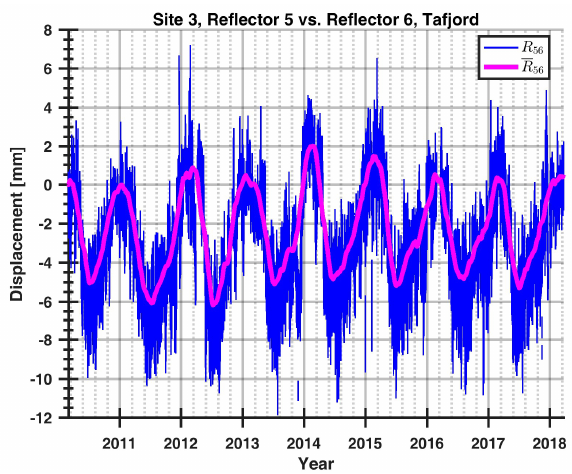
Figure 17. Displacement as a function of time for Site 3; reflector 5 referenced to reflector 6. The blue line is the raw-data while the red line is the three-months moving average. There is no displacement detected of Site 3 except for the annual cyclic motion.